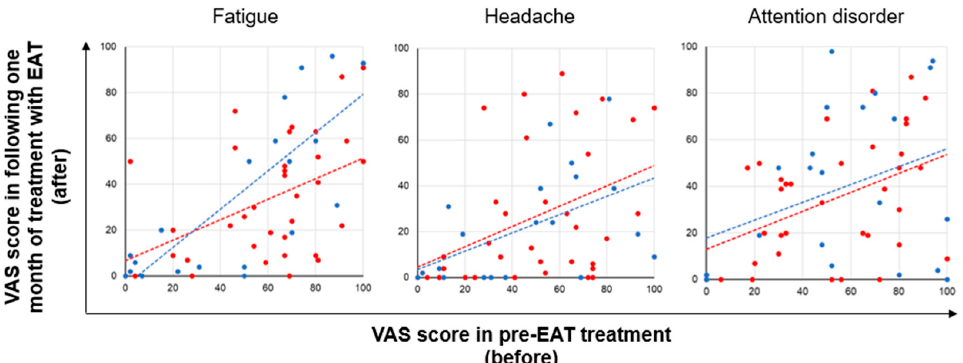
Figure 4. Visual analog scale (VAS) scores pre-epipharyngeal abrasive therapy (EAT) treatment (before) and following one month of treatment with EAT (after). Red circles indicate 35 patients with an inflammatory grade improvement of 1 or more. Blue circles indicate 23 patients without an inflammatory grade improvement. Dashed lines are added to guide the eye.